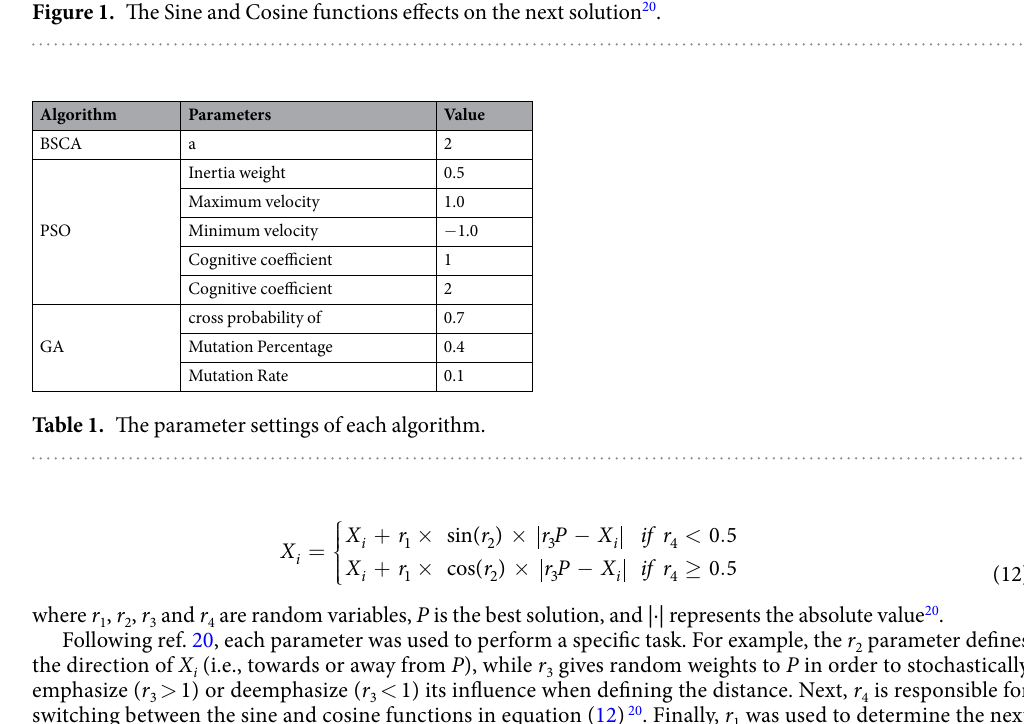
Figure 1. The Sine and Cosine functions effects on the next solution 20 .